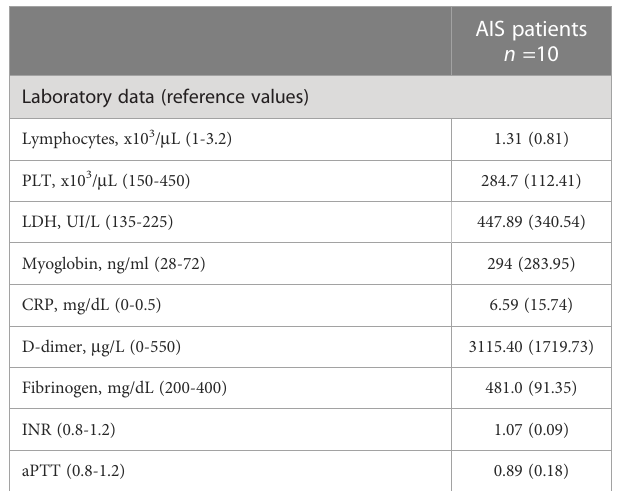
TABLE 1 Demographics and clinical characteristics of the COVID-19/AIS patients.